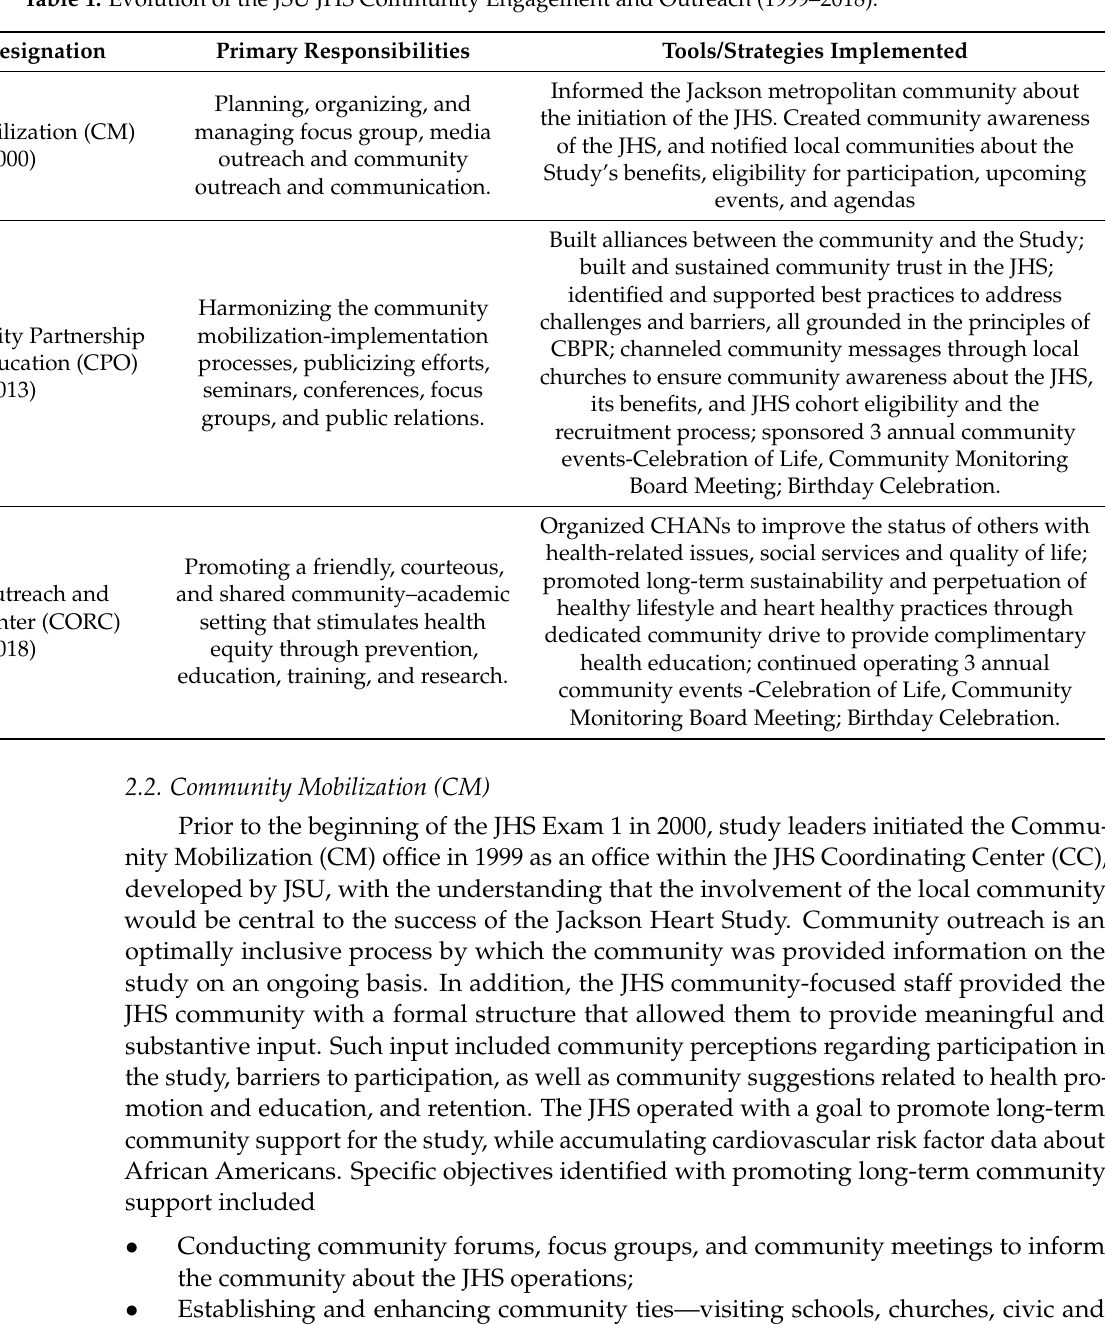
Table 1. Evolution of the JSU JHS Community Engagement and Outreach